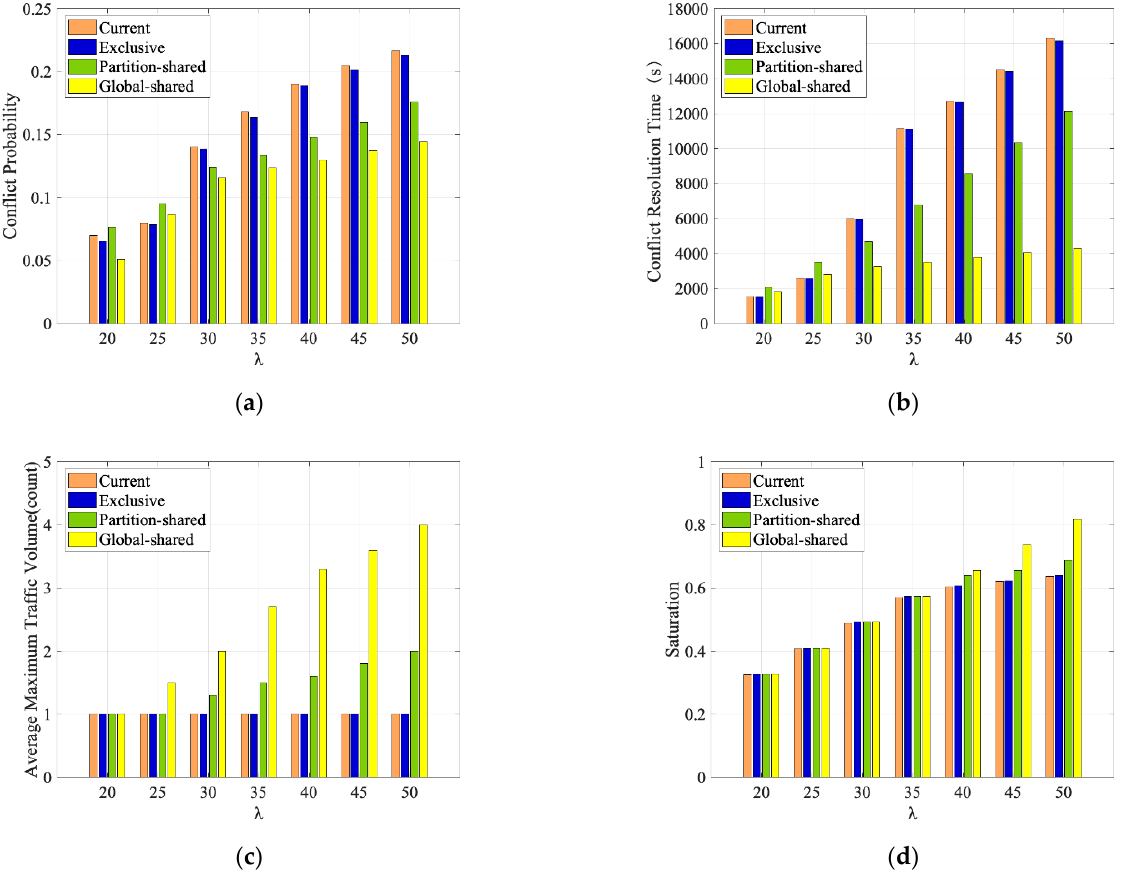
Figure 9. Relationship between Flight Quantities and Different Indices Using Different Operation Procedures. Procedures. ( a ) Relationship between Flight Quantities and Conflict Probabilities Using Different Operation Program; ( b ) Relationship between Flight Quantities and Conflict Resolution Times Using Different Operation Program; ( c ) Relationship between Flight Quantities and Average Maximum Traffic Volume Using Different Operation; ( d ) Relationship between Flight Quantities and Saturation Using Different Operation